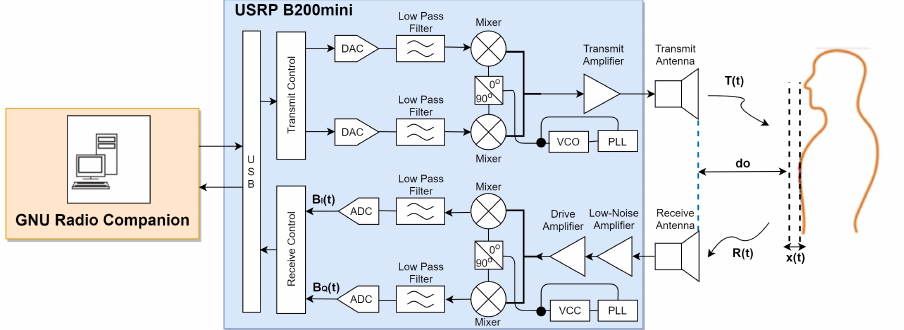
Figure 1. Block diagram of quadrature radar